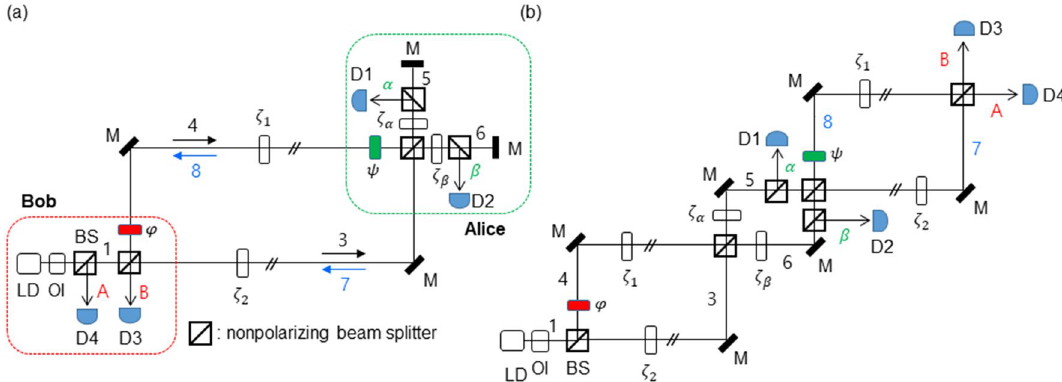
Figure 1. A schematic of USCKD. ( a ) An original schematic of USCKD. ( b ) An unfolded schematic of ( a ). LD: laser diode, OI: optical isolator, BS: nonpolarizing beam splitter, D: detector, M: mirror. ζ j : environmental phase noise. The numbers indicate corresponding electric